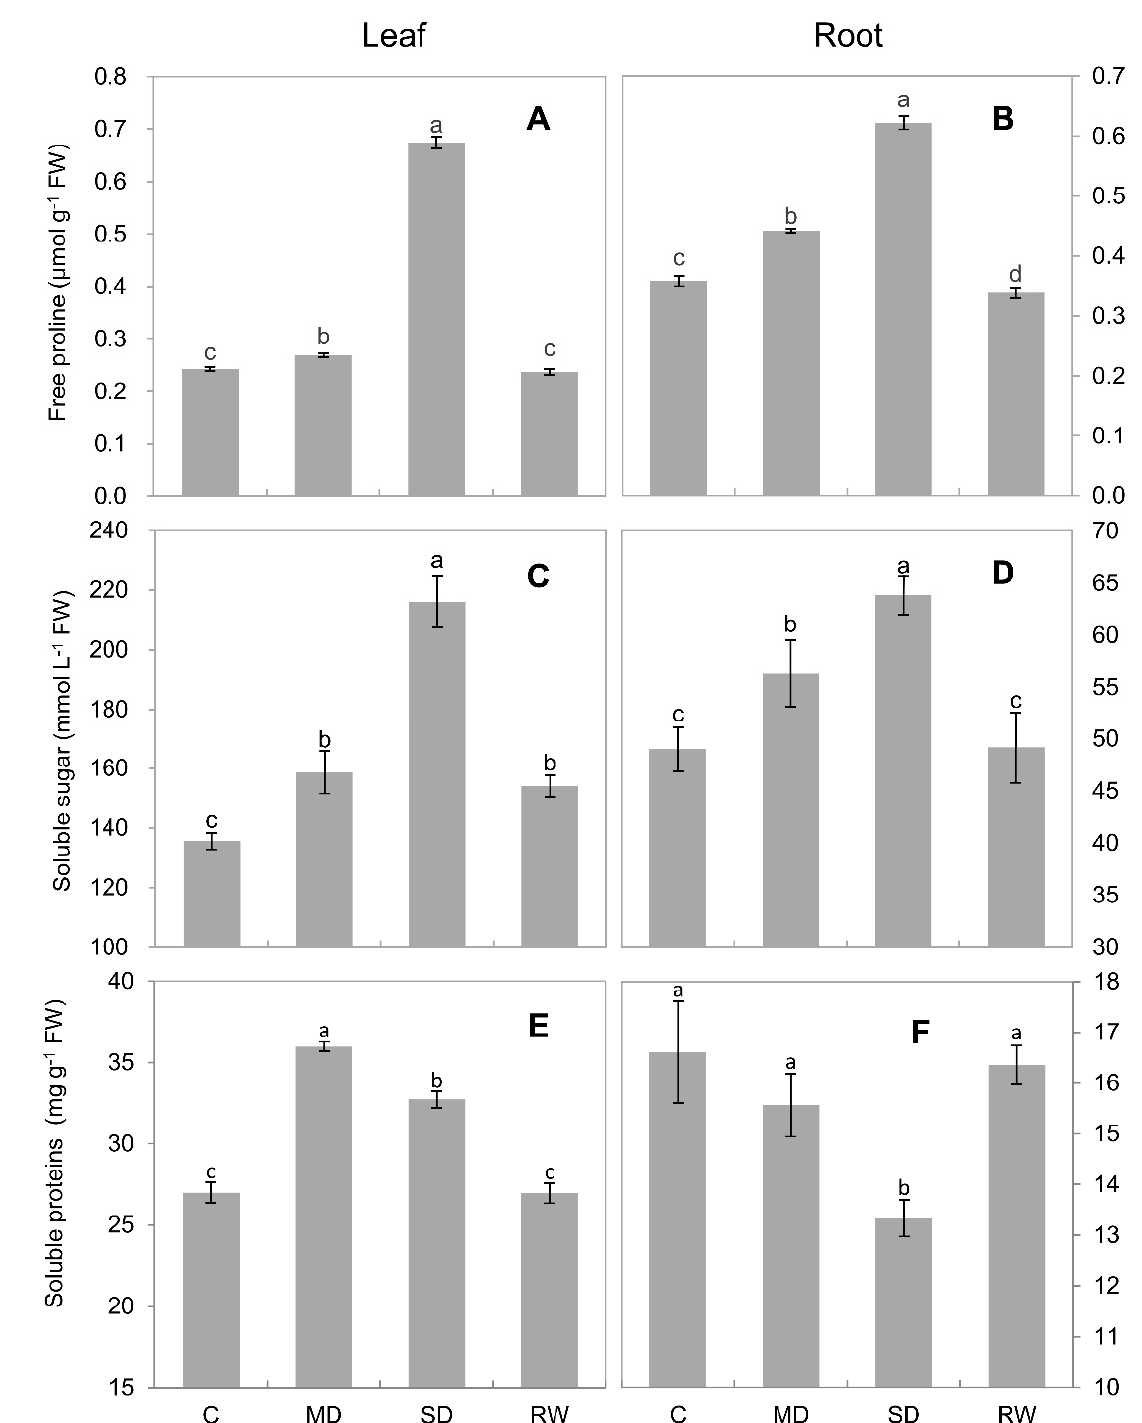
Figure 6. Effects of drought stress on the content of compatible solutes and soluble proteins in C. duriuscula . C-control, MD-mild stress, SD-severe stress, RW-re-watering. ( A , B ) proline content. ( C , D ) soluble sugars content. ( E , F ) soluble proteins content. Data are means ± SE ( n = 3–6). data labeled with different lower-case letters are significantly different at p < 0.05.